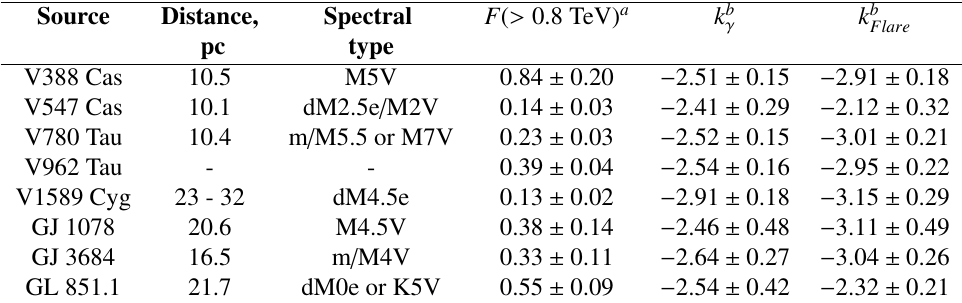
Table 1. Red stars of Flare star catalogue [1] viewed by